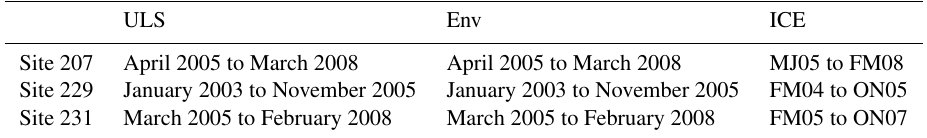
Table 3. Respective operation times of the ULS, Envisat (Env) and ICESat (ICE) sea ice thickness data sets during the comparison between ULS and satellite